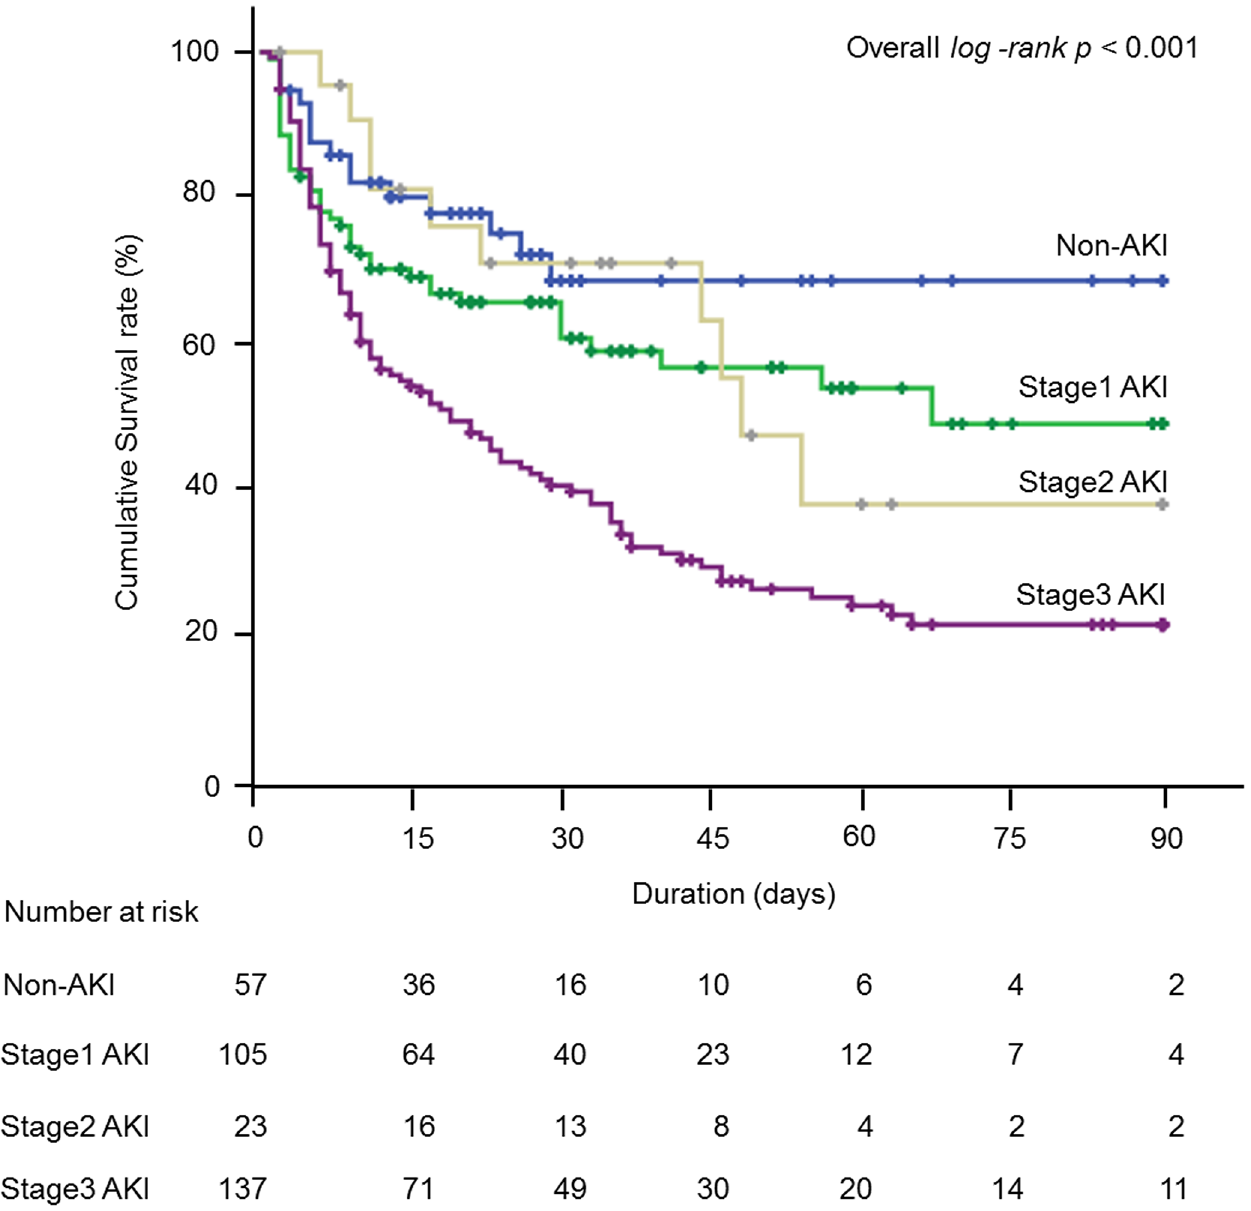
Fig 1. Kaplan-Meier survival curves for in-hospital mortality according to the stages of acute kidney injury. AKI, acute kidney